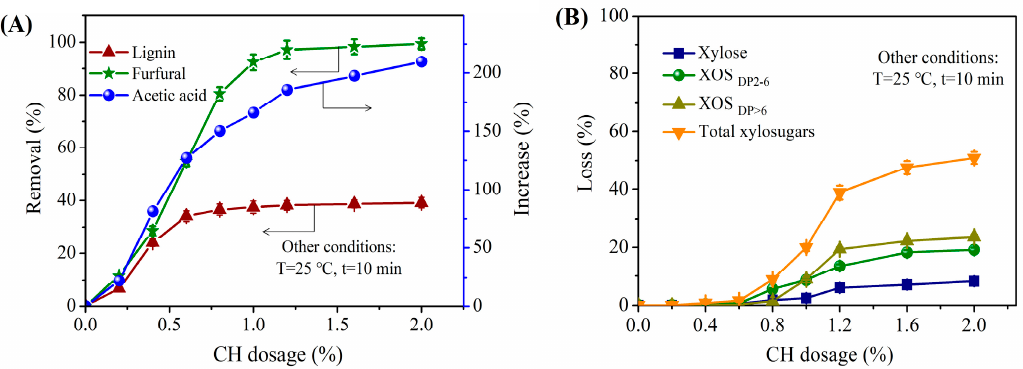
Figure 3. Influence of CH dosage on ( A ) the contaminant removal (furfural and lignin) and acetic acid increase of the original PHL and ( B ) the loss of xylose, XOS DP2~6 , XOS DP > 6 , and total xylosugars.